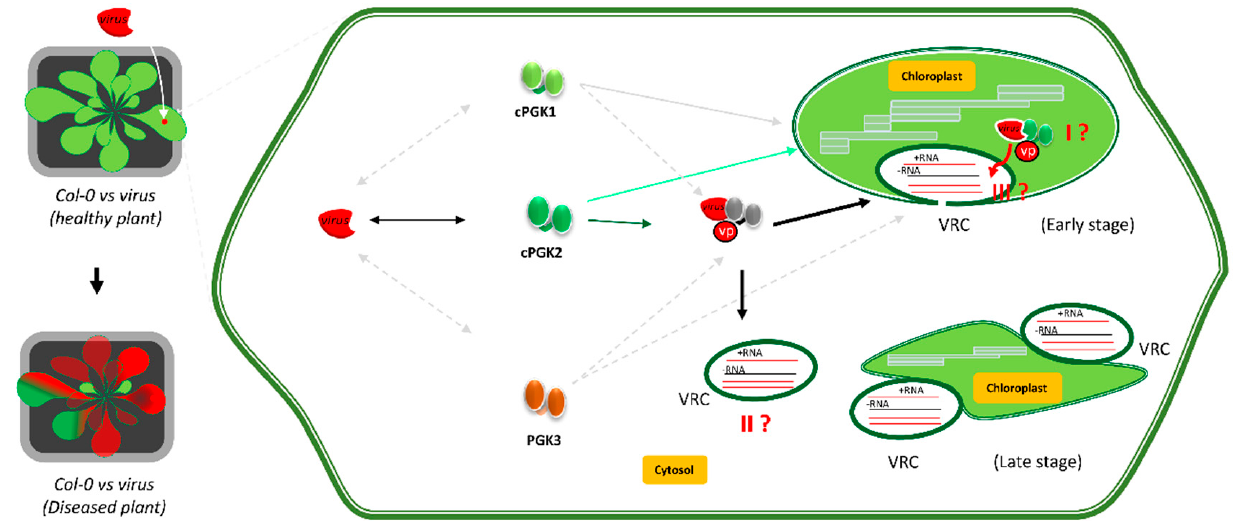
Figure 5. Illustration model of a potyvirus replicating in susceptible Arabidopsis thaliana plants, using the phosphoglycerate kinases (PGK) as host factors and the chloroplast membrane as a replication site in the early (normal chloroplast) and late (damaged chloroplast) infection stages. The three Arabidopsis PGKs are presented: cPGK1, cPGK2, and PGK3, with the Watermelon mosaic virus (WMV), which is known to infect Arabidopsis through cPGK2. Three hypotheses are shown: I—WMV is transported in the chloroplast, where it recruits the targeted cPGK2. II—cPGK2 is hijacked in the cytosol, before being targeted to the chloroplast, or because some of it is targeted to the cytosol through alternative splicing or translation through Met2. III—at the later stage of the infection, and following damages in the chloroplast, the chloroplastic cPGK2 leak out from the chloroplast to the viral replication complexes (VRC).